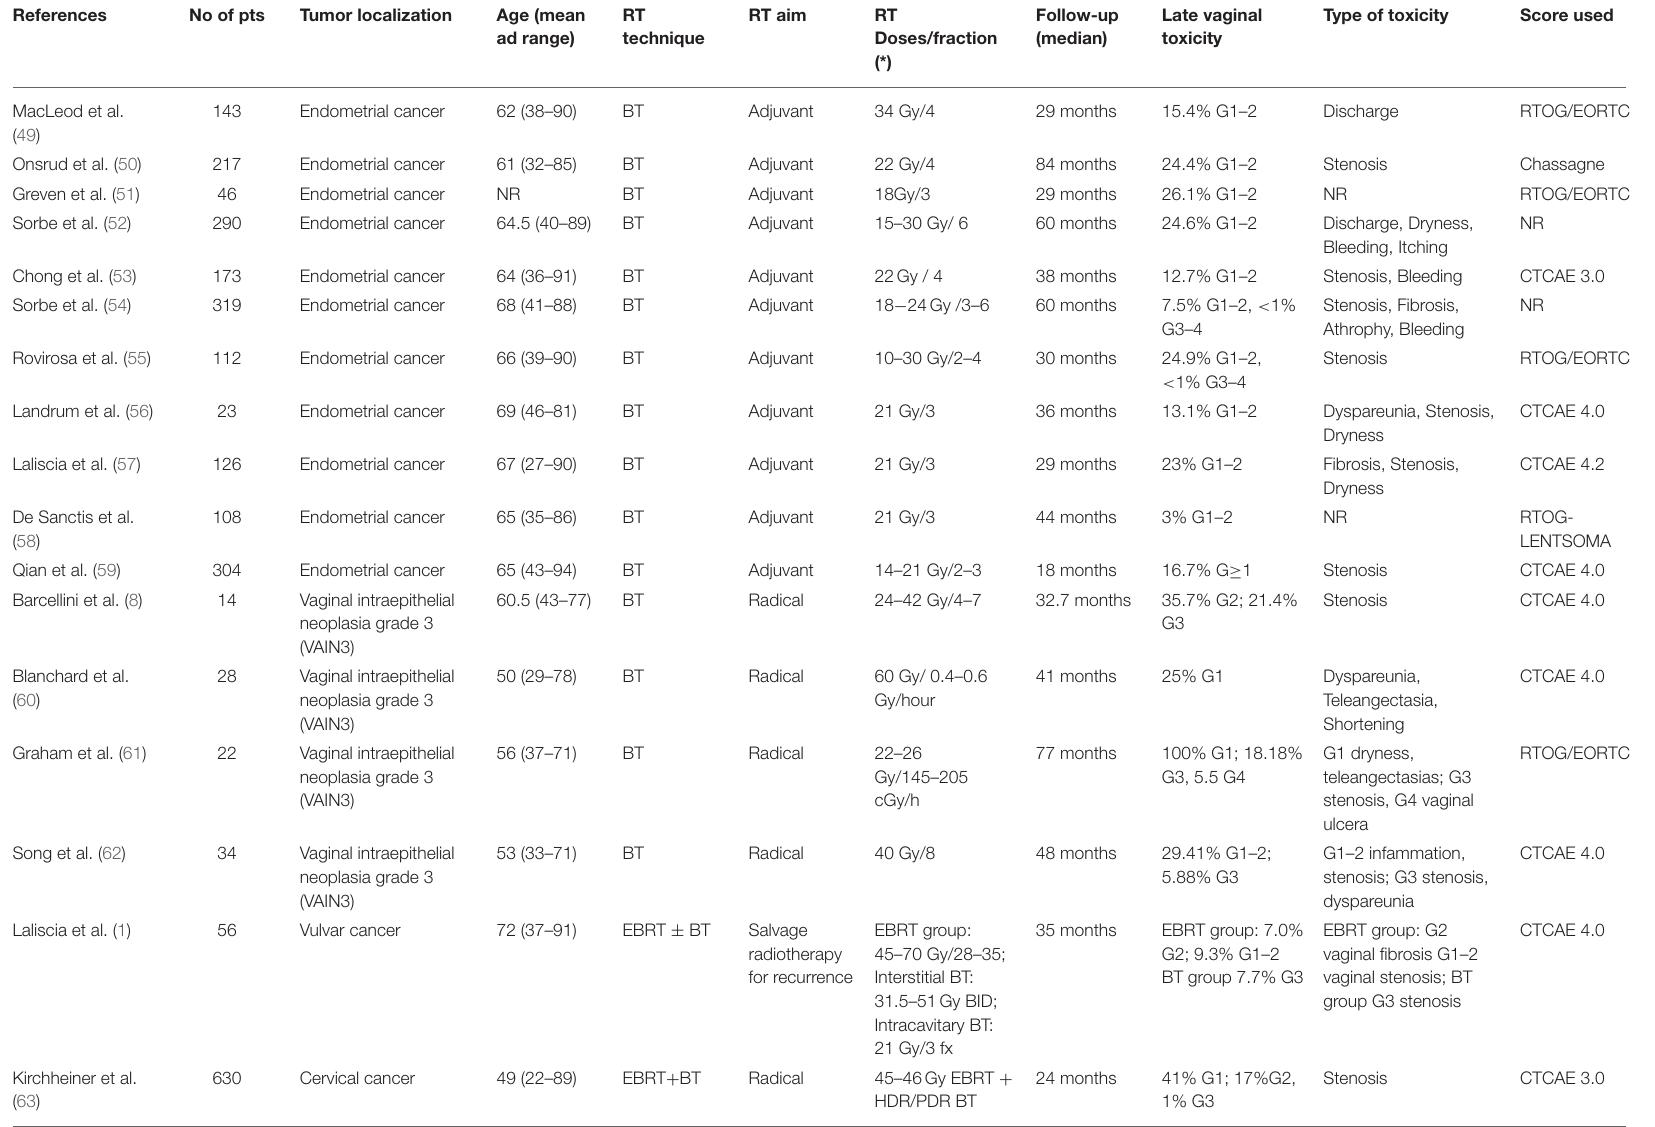
TABLE 2 | Radiotherapy toxicities in the analyzed